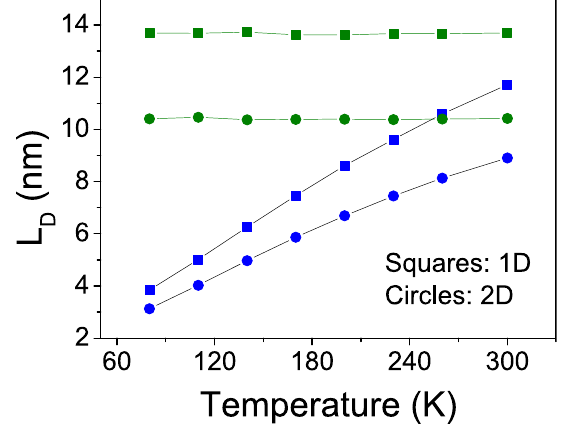
Figure 2. Diffusion lengths in 6 T (green) and P6P (blue) for the 1D (squares) and 2D (circles) morphologies as a function of